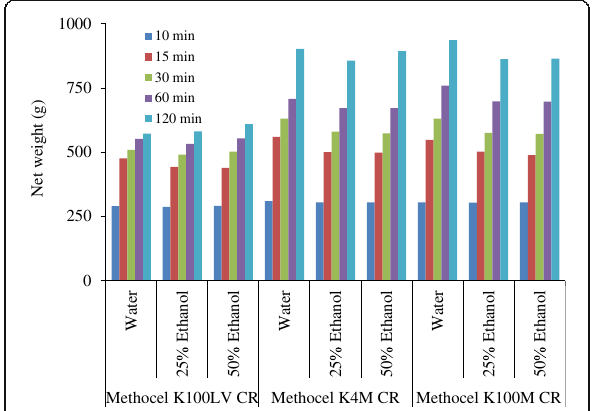
Fig. 24 Effect of ethanol on solubility of aspirin and its release exponent from hypromellose matrices (data from reference (Roberts et al.